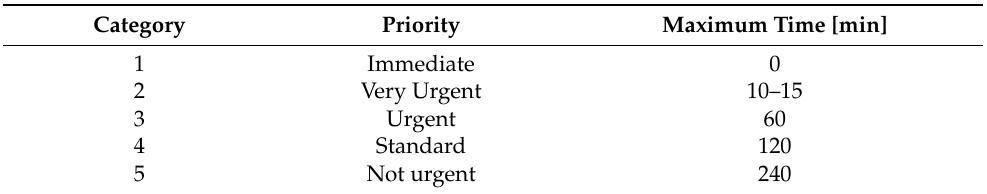
Table 1. Manchester